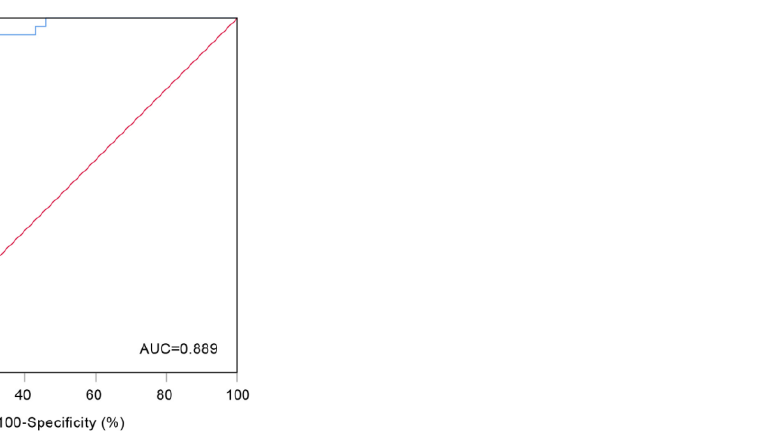
Figure 2. Receiver operating characteristic curve (ROC) obtained by the risk model based on logistic regression.